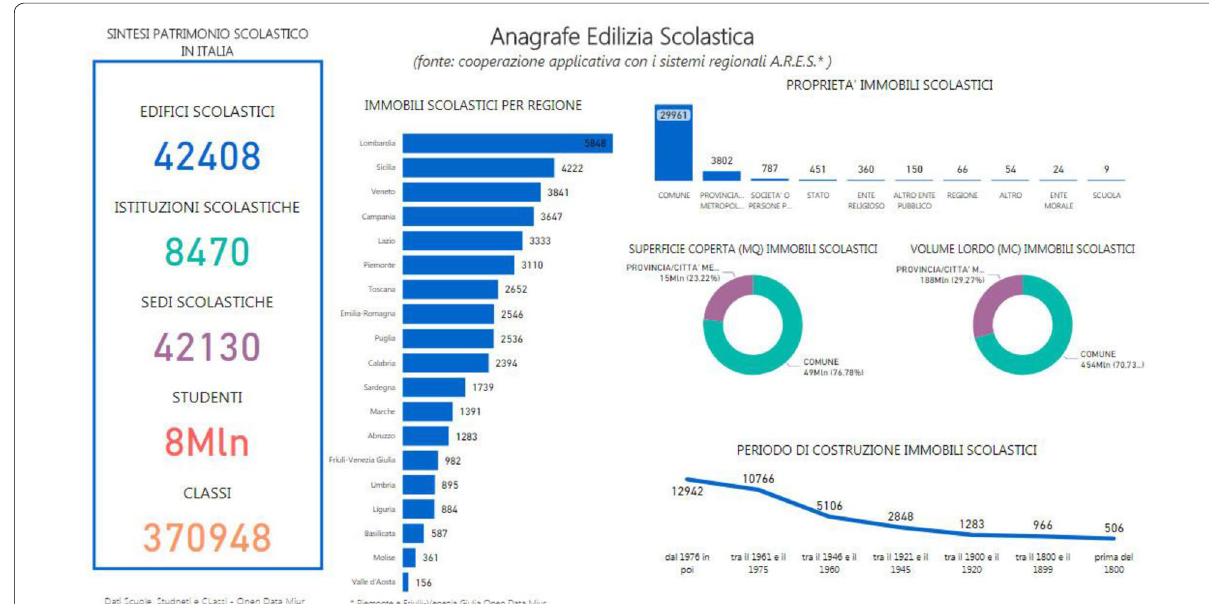
Fig. 1 The school building’s real estate in Italy. (Source: Governo. ItaliaSicura Scuole. http://www.canti erisc uole.it/bei.html Accessed 10 January 2018, the site has not been updated since the SMES closure, since January 2019 no longer available online)